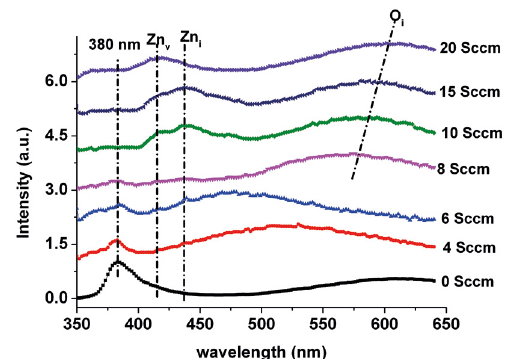
simultaneously with an orientation changement from (002) to (100) which is consistent with the XRD